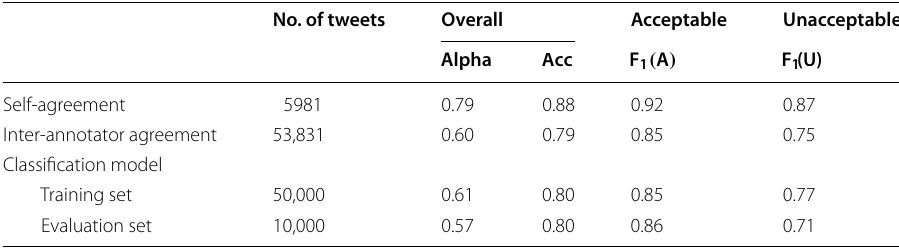
Three measures are used: ordinal Krippendorff’s Alpha , accuracy ( Acc ), and F 1 for the classes of acceptable (A) and unacceptable (U) tweets. The first line is the self-agreement of individual annotators, and the second line is the inter- annotator agreement between different annotators. The last two lines are the evaluation results of the model, on the training set (by cross validation) and on the out-of-sample evaluation set, respectively. Note that the model performance is comparable to the inter-annotator